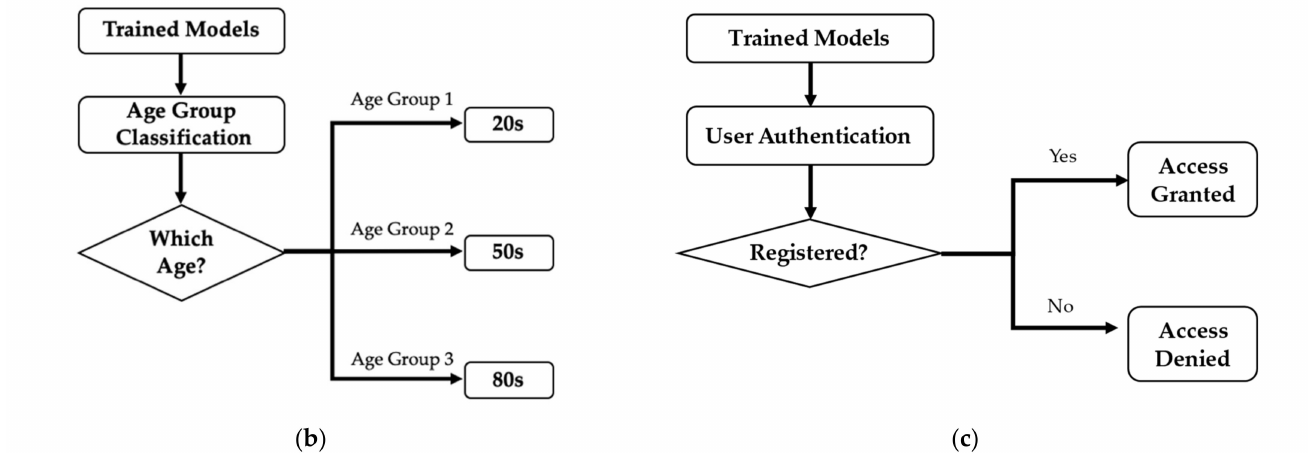
Figure 5. A flow of implementing deep learning-based authentication models: ( a ) A flow of implementing deep learning- based authentication models; ( b ) application: age group classification; ( c ) application: user